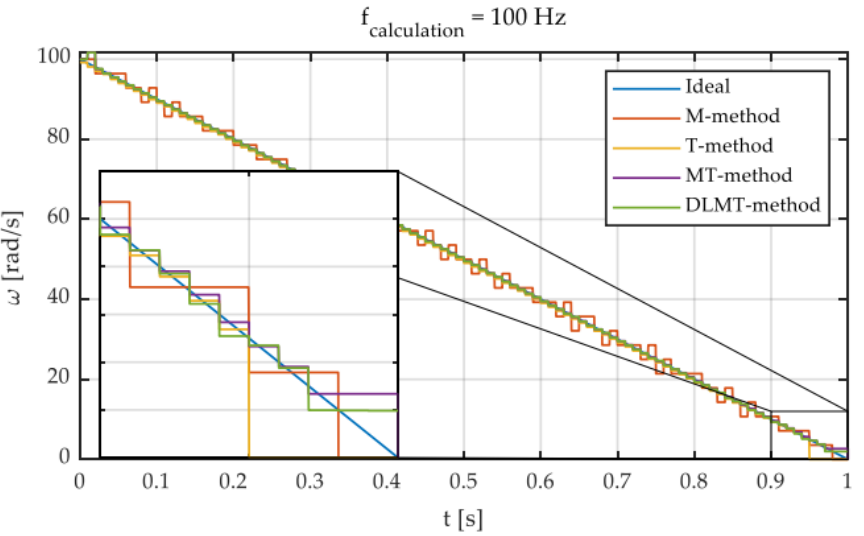
Figure 6. Main differences between M, T, MT, and DLMT speed measurement algorithms [15] .